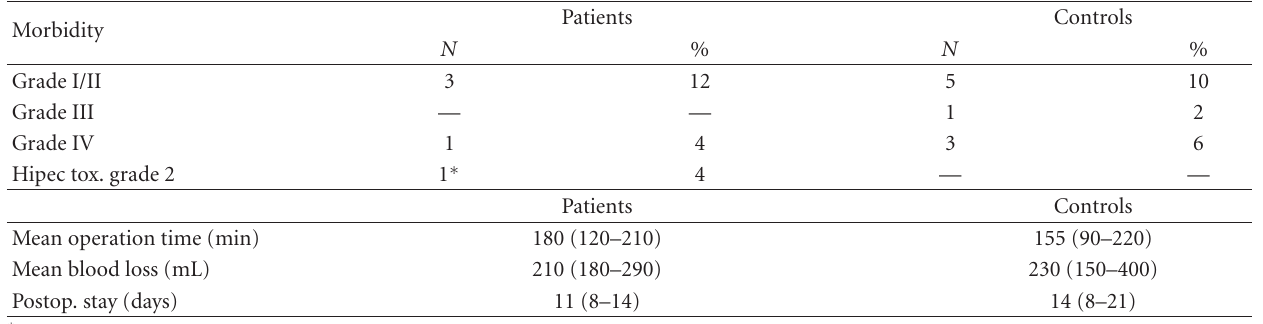
Table 3: Surgical outcome in the 2 groups.